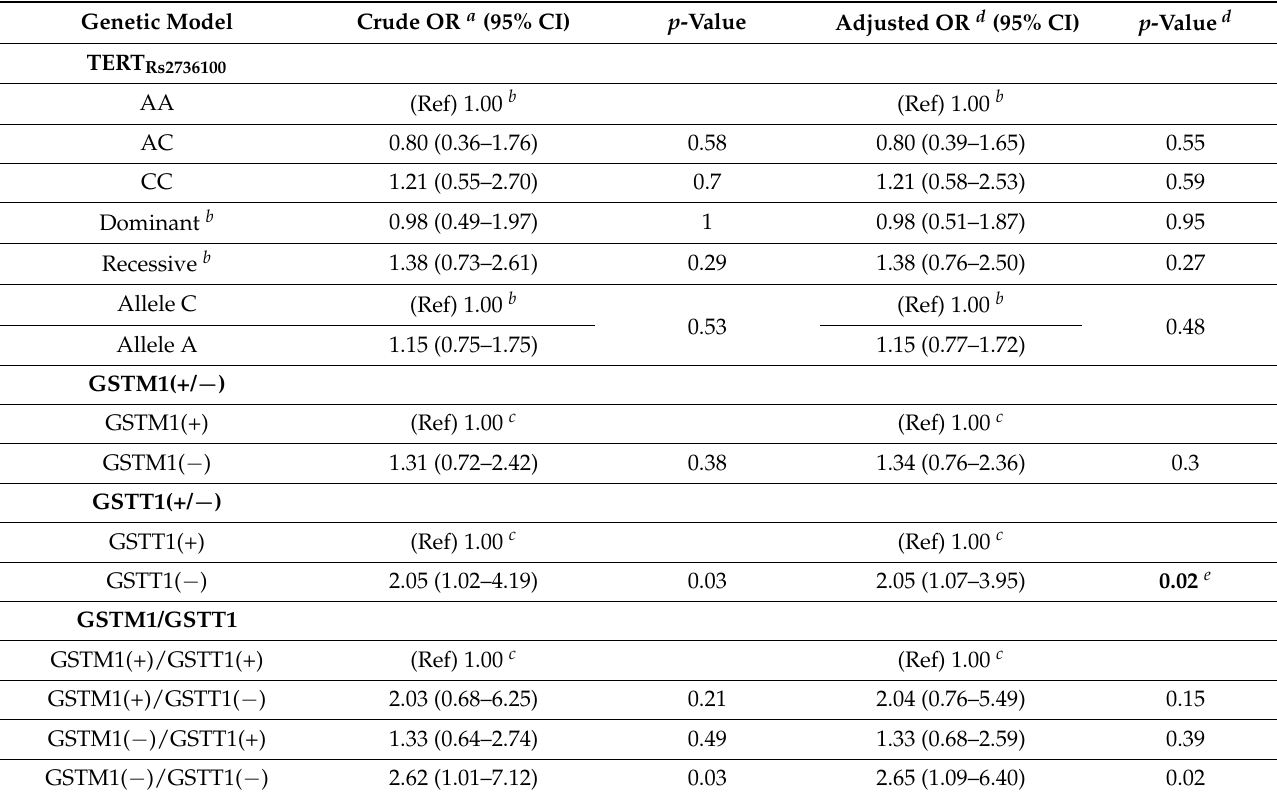
Table 4. Relationship between TERT Rs2736100 , GSTM1, and GSTT1 genotypes, and laryngeal cancer susceptibility.